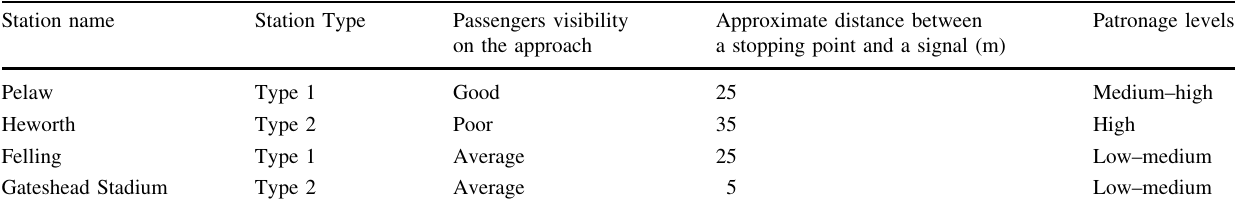
Table 2 Summary of station